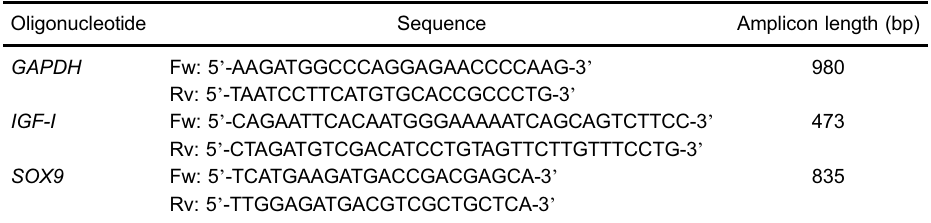
Table 1. Primers used for the ampli fi cation of the GAPDH , IGF-I , and SOX9 sequences.